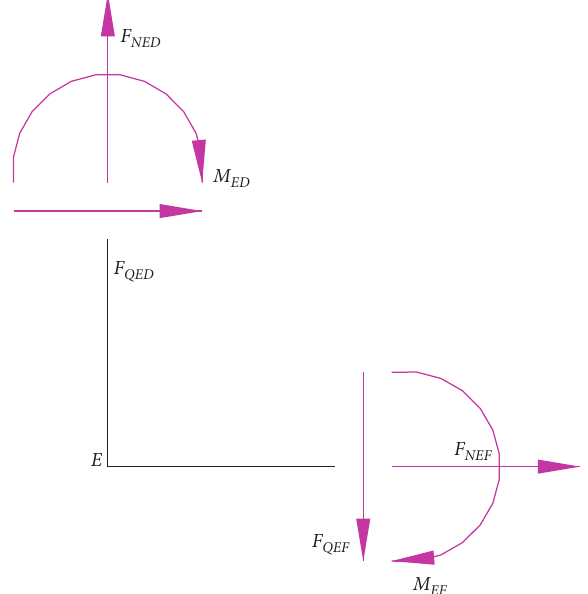
Figure 7: The internal stress at Node E of DEF . The resultant force at Node E of DEF along the x -direction and y -direction is 0, while the resultant moment at Node E of DEF is 0.